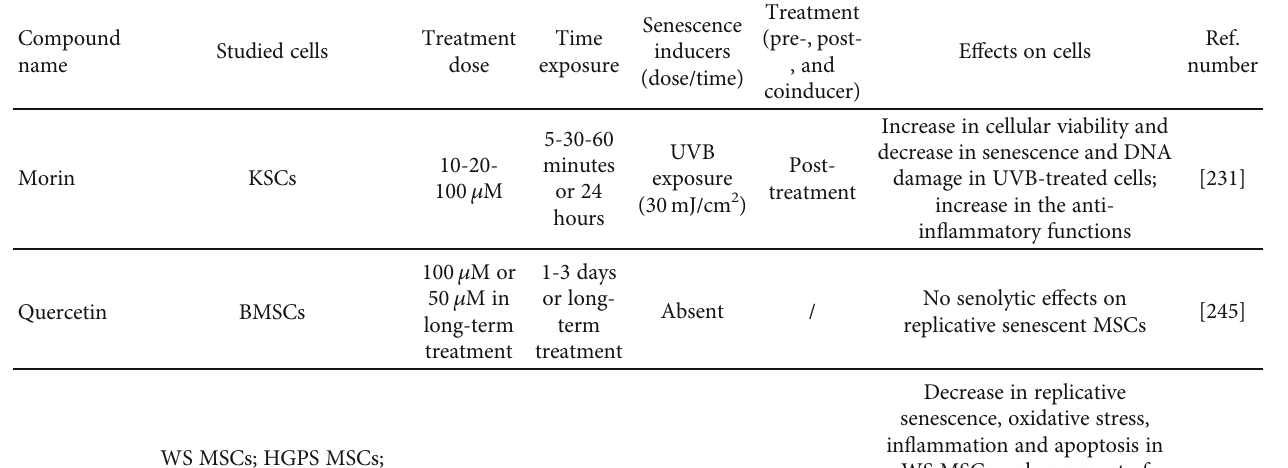
Table 3: Known herbal active compounds with an antisenescence role on human senescent